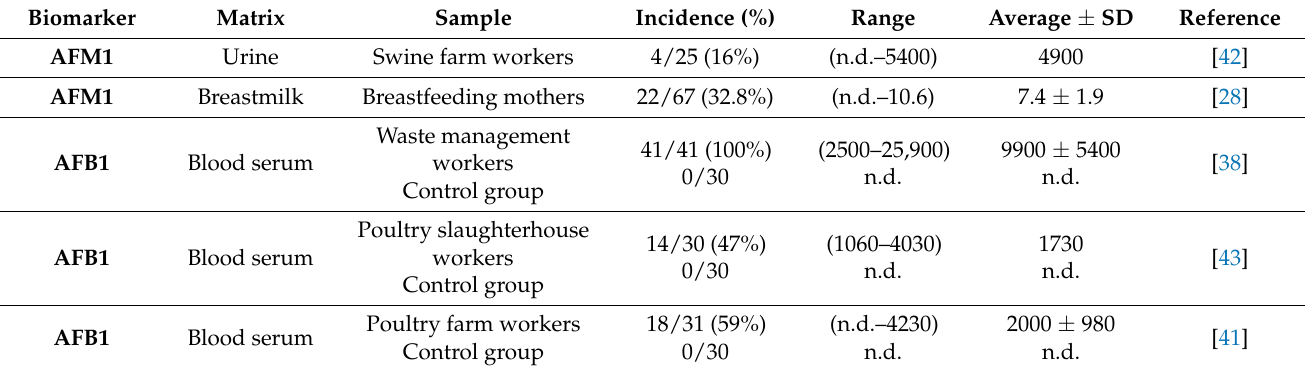
Table 1. The occurrence and levels (ng L − 1 ) of aflatoxins (AFM1 and AFB1) in different biological samples collected among the Portuguese